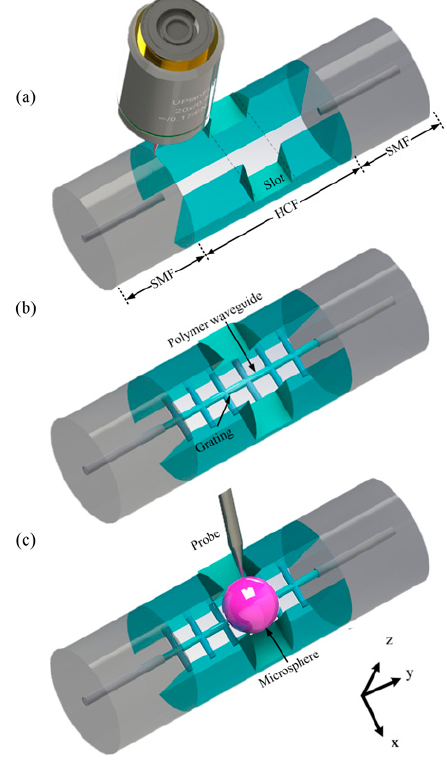
Figure 2. Fabrication procedure for the proposed WGM resonator. ( a ) A fs-laser was employed to realize subtractive manufacturing (ablation) after a section of hollow-core fiber (HCF) spliced between two single-mode fibers (SMFs). ( b ) A polymer waveguide was printed by additive manufacturing (polymerization) assisted with a fs-laser to connect the two SMFs. The grating segment was similarly printed. ( c ) A microsphere was mounted upon the polymer waveguide to generate WGM resonance.